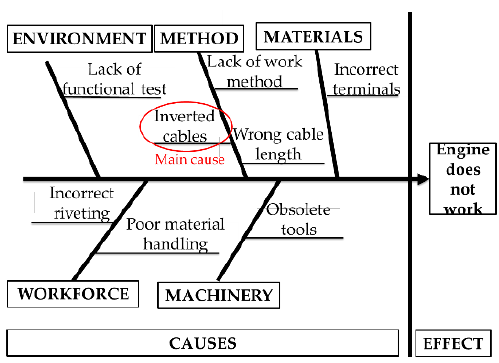
Figure 8. Cause-effect diagram to find out the root cause of the problem. Figure 8. Cause-e ff ect diagram to find out the root cause of the